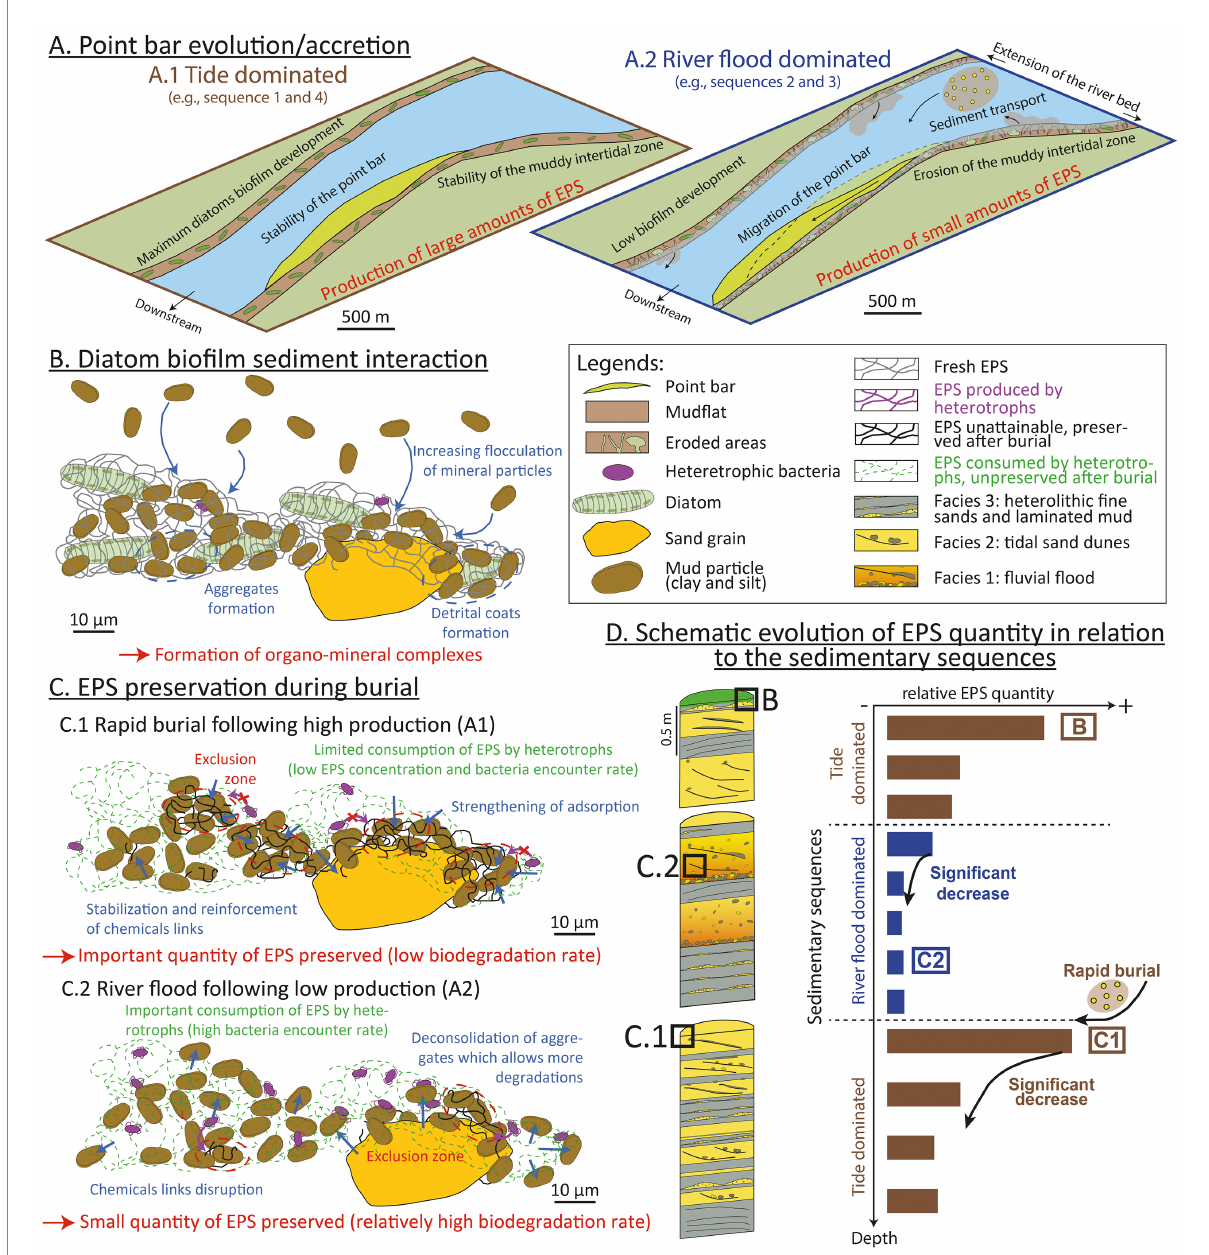
FIGURE 8 Multiscale scenario explaining the role of the hydro-sedimentary context and organo-mineral interactions in the production and preservation of exopolymeric substances (EPSs) in estuaries. (A) Sketch of the Bordeaux North point bar during a tide-dominated period (A.1; brown) and a river flood-dominated period (A.2; blue). Biofilm development and EPS production are optimal during tide-dominated intervals, when the point bar is stable and the muddy intertidal domain well developed. During river flood-dominated periods, the migration of the point bar coupled to the erosion of the intertidal zone results in lower EPS production. (B) Formation of clay-EPS complexes: clay-EPS aggregates and detrital coats in surface sediments. (C) The preservation of clay-EPS complexes and EPSs during burial depends on the sedimentation rate: (C.1) rapid burial following, e.g., a river flood protects EPSs from heterotrophic degradation; and (C.2) normal sedimentation rate leads to increased EPS degradation. (D) Vertical trends of EPS concentrations depend on production and sedimentation. Tide-dominated periods followed by rapid burial create the optimum conditions for EPS preservation, while river flood-dominated periods followed by tide-dominated periods are associated with low EPS